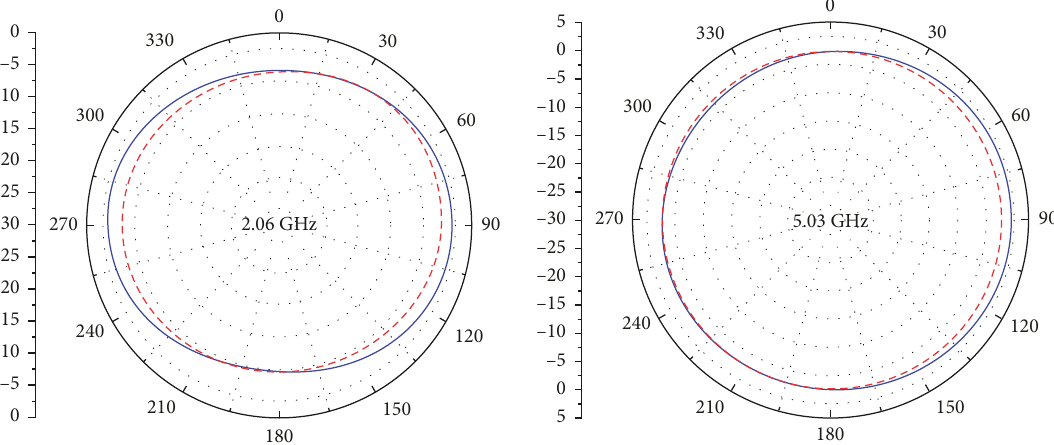
Figure 4: The radiation pattern of the proposed MSB antenna.